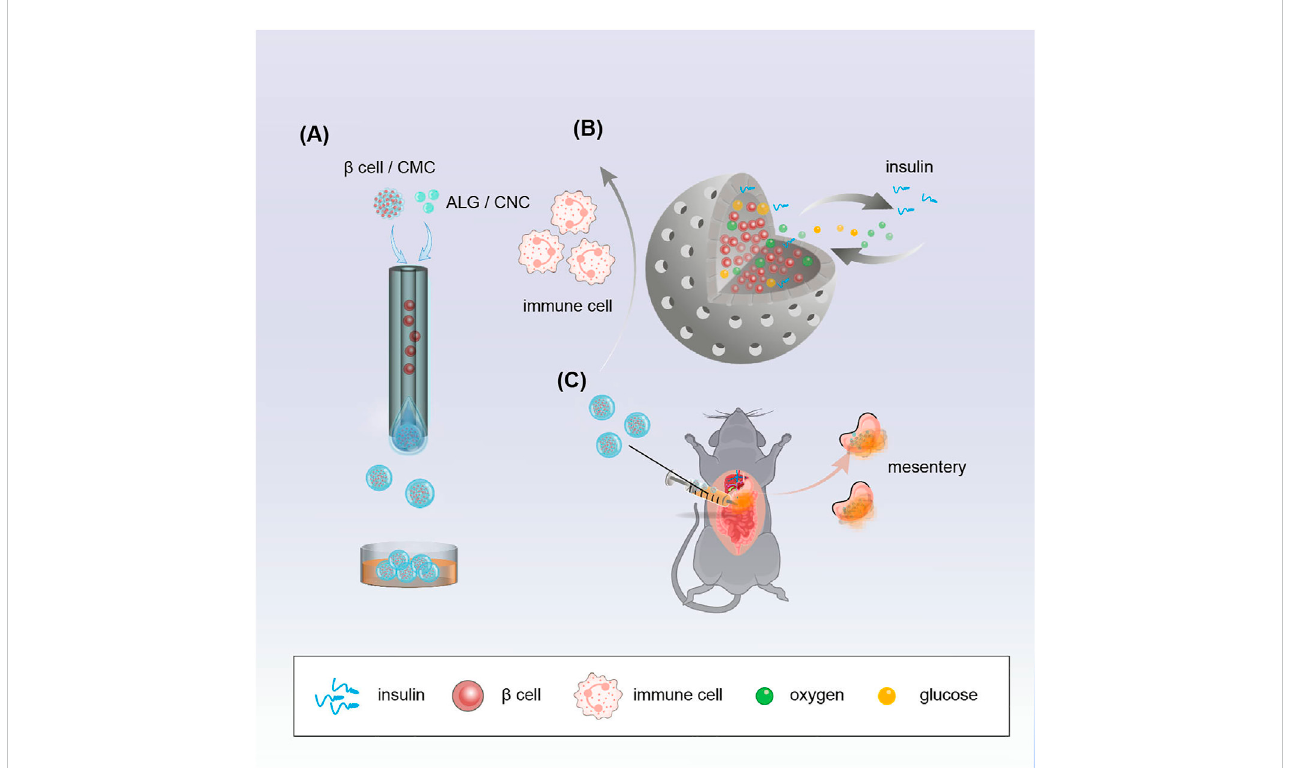
Schematic demonstrating the fabrication of porous microcapsules encapsulating β cells for diabetes treatment after mesentery transplantation in diabetic mice. (A) Porous microcapsules fabricated via the micro fl uidic electrospray system. (B) β -cell-encapsulated microcapsules isolate immune cells, release insulin, and exchange oxygen and glucose. (C) β -cell-encapsulated porous microcapsules were applied to treat diabetes in diabetic mice after mesentery transplantation.